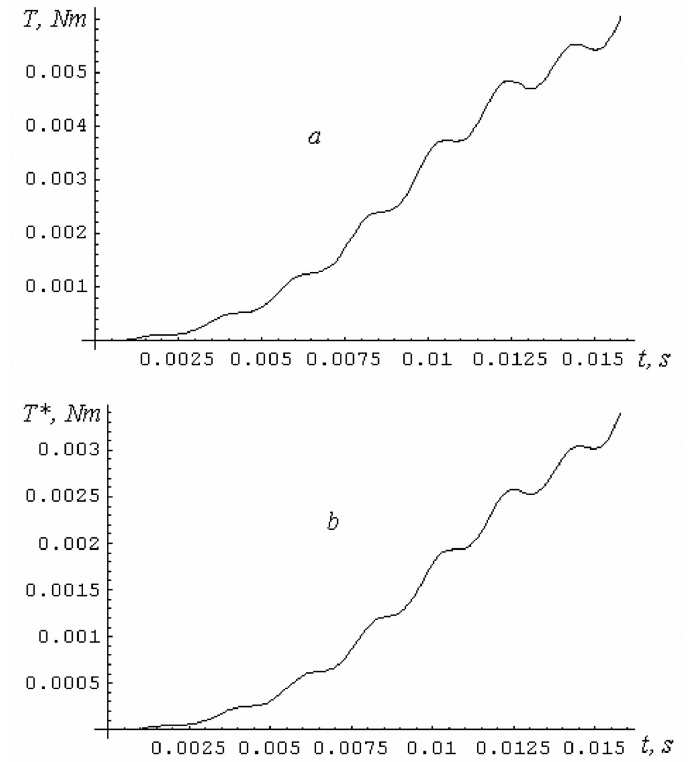
Fig. 8. Kinetic energy of the handle and limbs during string and arrow joint motion when there is no stabilizer on the bow (a) and when the same bow is equipped with a multi-rod stabilizer (b). of its free end. The monotonic nature of these movements reveals that this process is operating below the resonant frequency of the